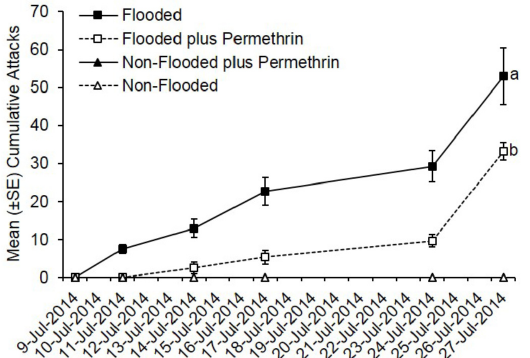
Table 1. Influence of flooding and preventive insecticide treatment on attacks and colonization